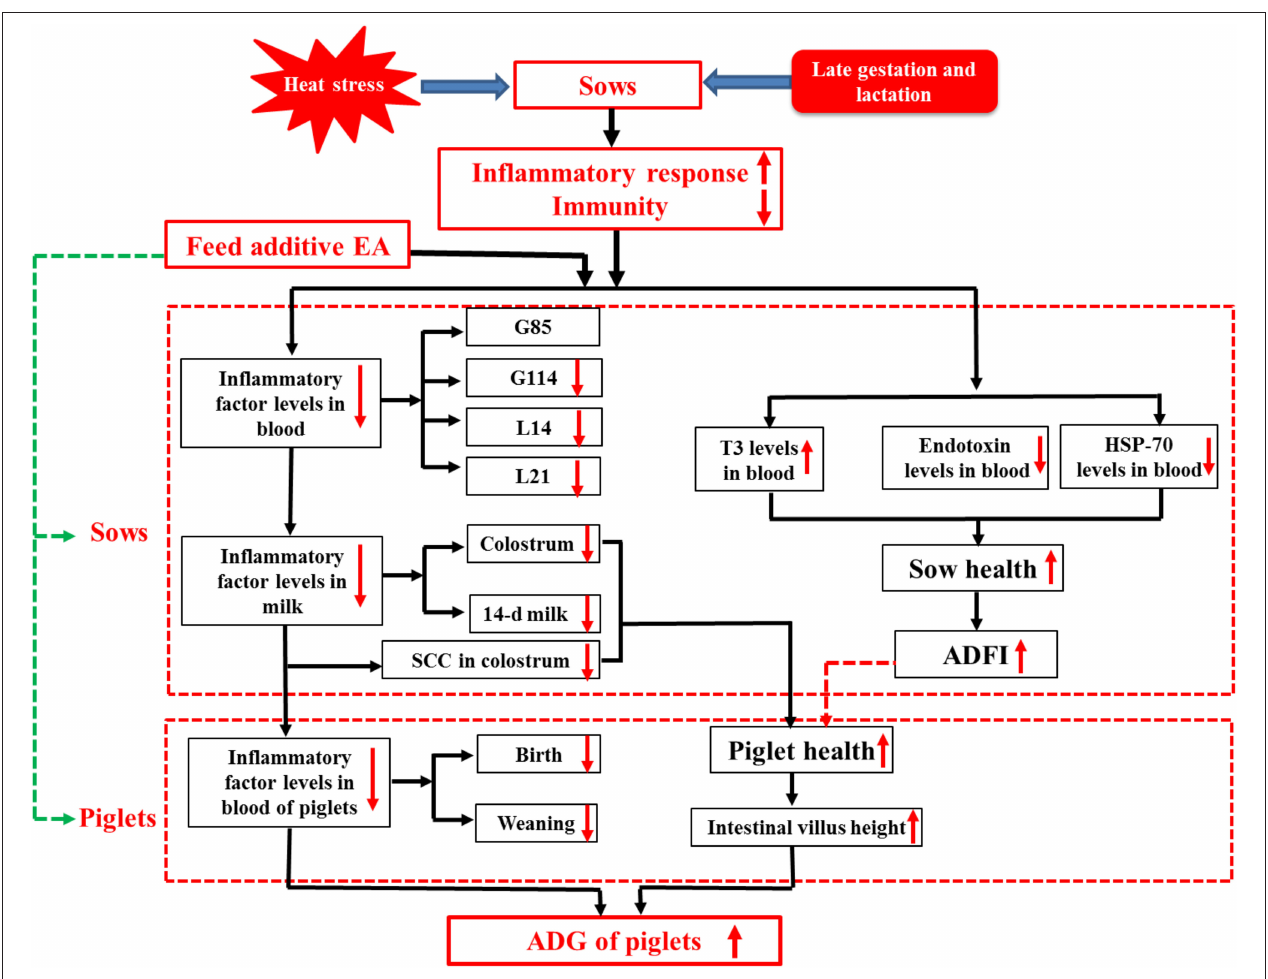
FIGURE 1 | Dietary enzymatically treated Artemisia annua L. (EA) supplementation at 1.0 g/kg during late gestation and lactation increased ADFI, decreased endotoxin and inflammatory factor levels in the serum and colostrum of heat-stressed sows during lactation, and increased ADG and improved the gut development of their